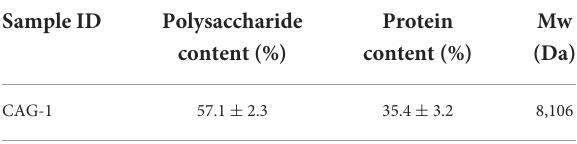
The asymmetric ring stretching vibration was performed at TABLE 1 The polysaccharide content, protein content, and molecular weight of crude chickpea glycoprotein-1